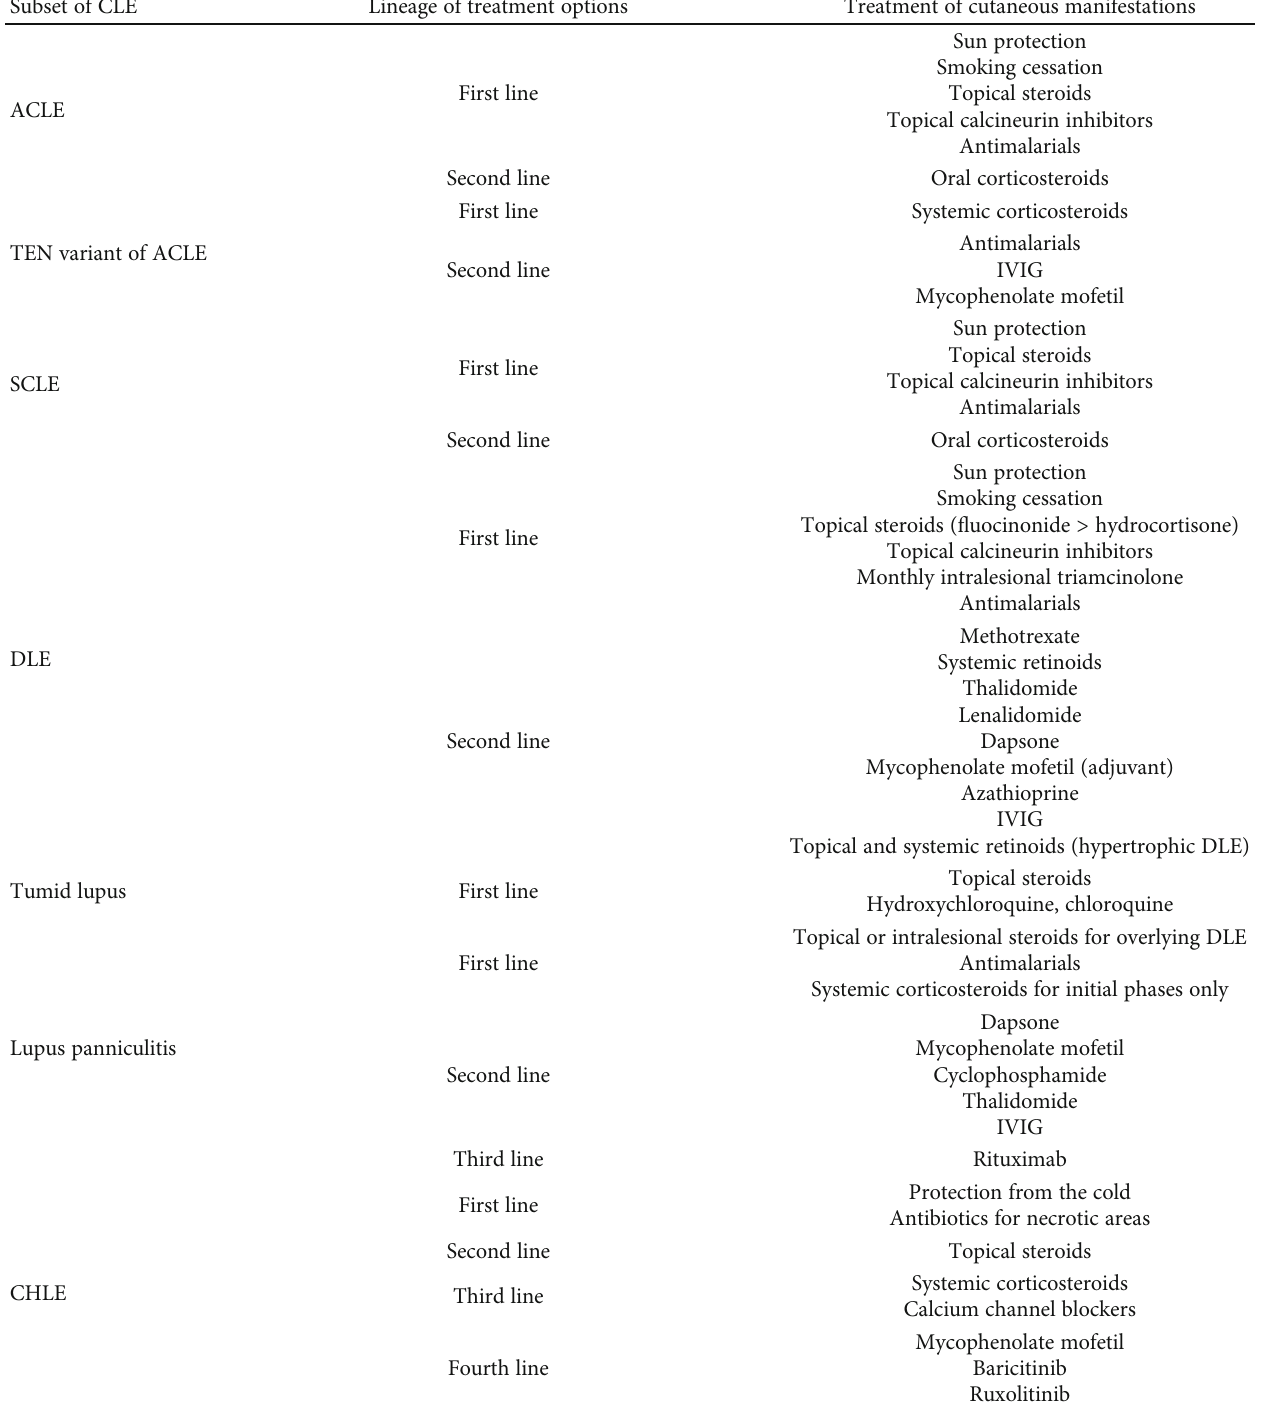
Table 1: A summary of treatment options for cutaneous lesions, in order of recommendation, distinct for each diagnostic category of cutaneous lupus. Abbreviations: CLE, cutaneous lupus erythematosus; ACLE, acute cutaneous lupus erythematosus; TEN, toxic epidermal necrolysis; IVIG, intravenous immunoglobulin; SCLE, subacute cutaneous lupus erythematosus; DLE, discoid lupus erythematosus; CHLE, chilblain lupus erythematosus; LE/LP overlap, lichenoid cutaneous lupus erythematosus-lichen planus overlap